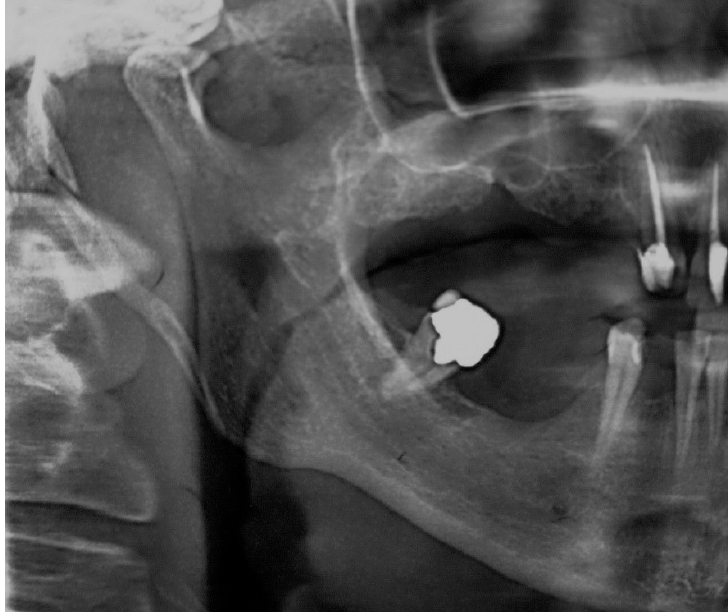
Figure 1. Cropped panoramic image showing pathologically elongated styloid process ending at the inner side of angle of mandible. The length of styloid process is 46 mm (conventional manual measurement with straight ruler).